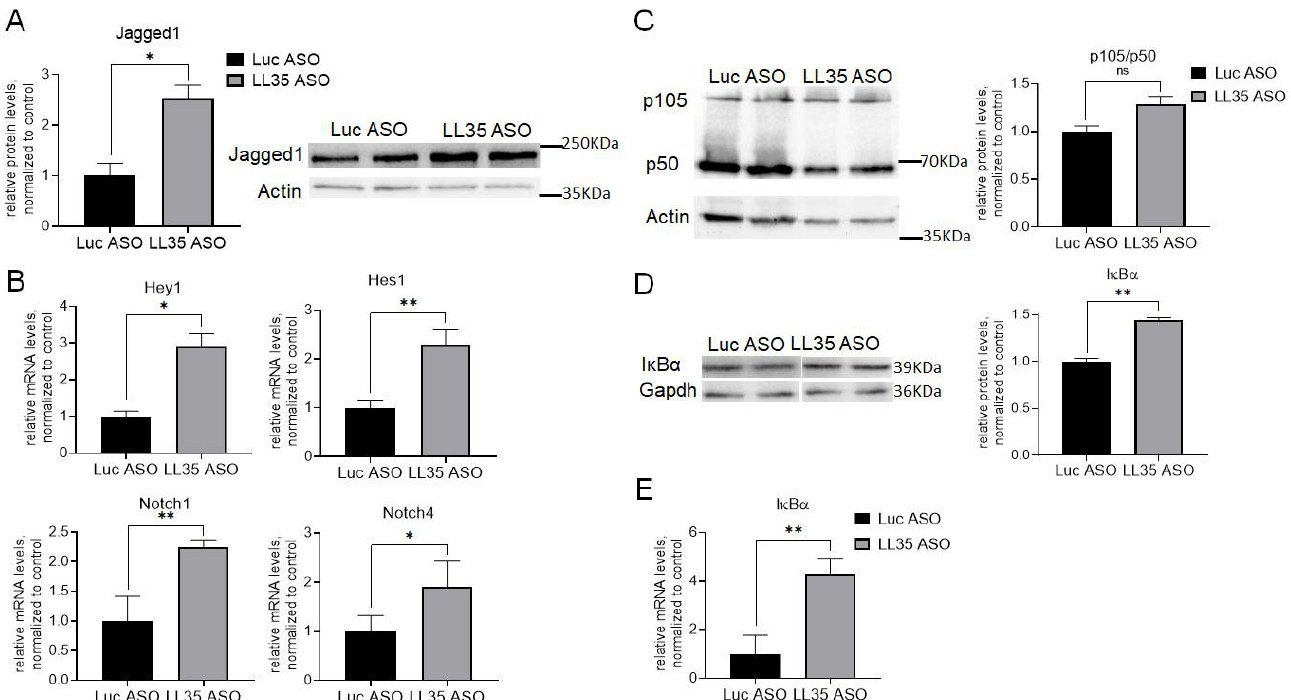
Figure 8. Changes in Notch and NF- κ B pathways after LL35 depletion in vitro. ( A ) Estimation of Jagged1 protein level after LL35 knockdown in vitro by western blot, normalized at ActB protein level. ( B ) RT-qPCR measurement of the mRNA expression levels of major genes involved in Notch signaling pathway after LL35 knockdown (LL35 ASO) in AML12 cells and control (Luc ASO), normalization on ACTB gene. ( C ) Estimation of p105/p50 proteins ’ ratio after LL35 knockdown in AML12 cells by western blot, normalized on ActB protein level. ( D ) Estimation o f IκBa protein level after LL35 knockdown by western blot, normalization on GAPDH protein level. ( E ) RT-qPCR measured expression levels of IκBa mRNA after LL35 knockdown and control. ACTB— reference gene. Results show mean ± SD. n.s. — not significant. * p < 0.05, ** p < 0.01.